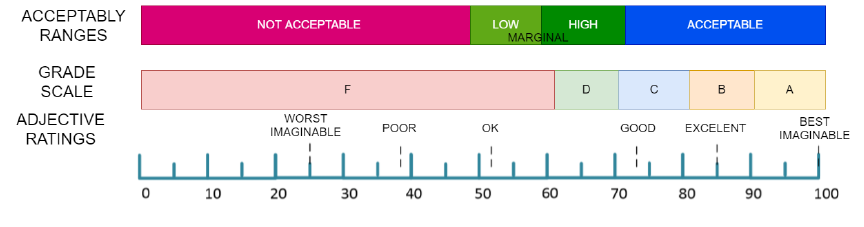
Figure 7. Grade rankings of SUS scores adapted from Reference [22].